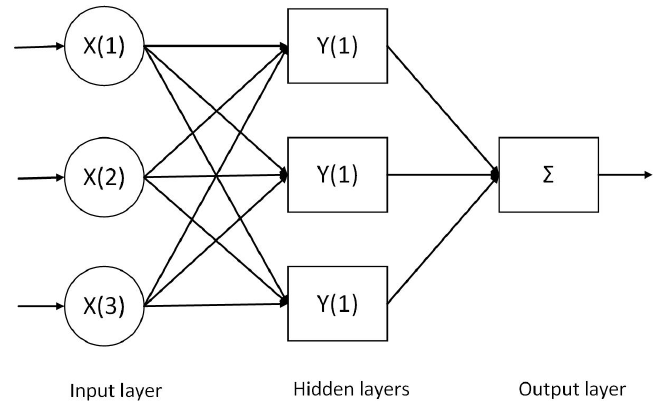
Figure 2. RBF neural network